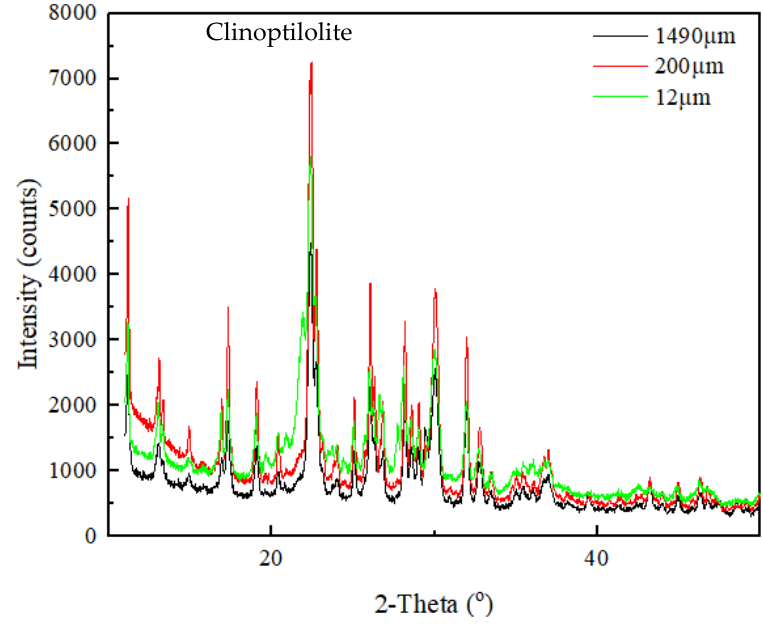
Figure 1. XRD pattern of the zeolite samples.